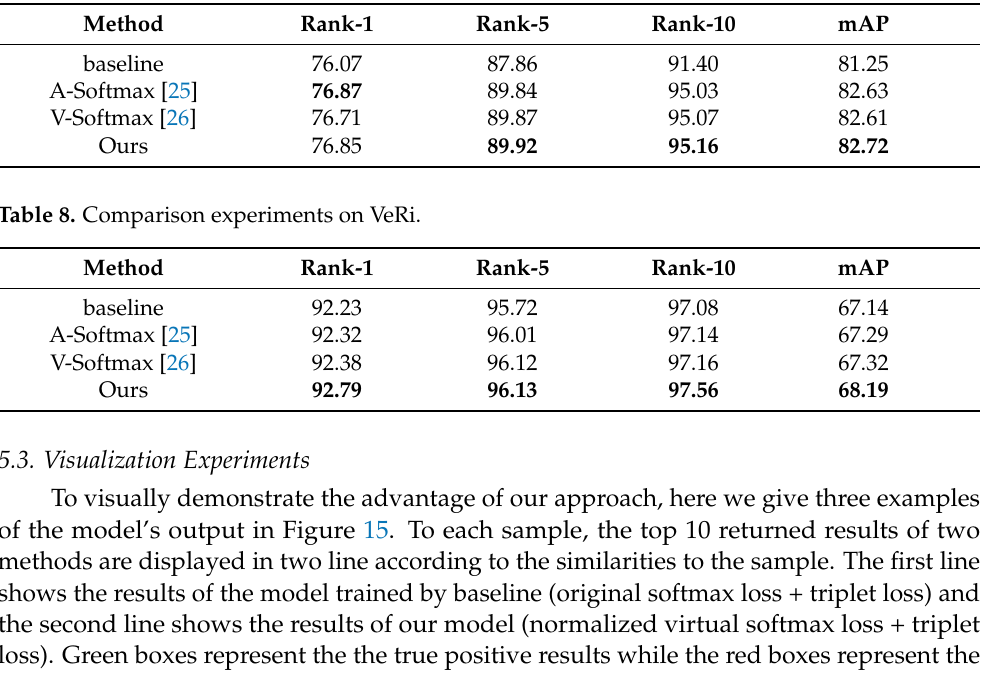
Table 7. Comparison experiments on VehicleID.